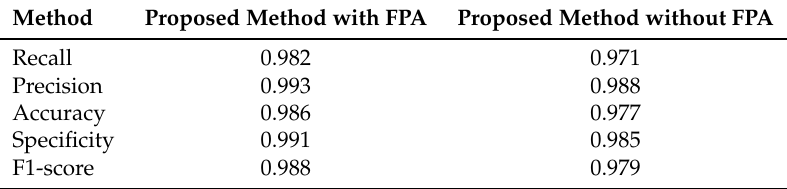
Table 4. Classification performance comparison on the proposed FPA optimization.